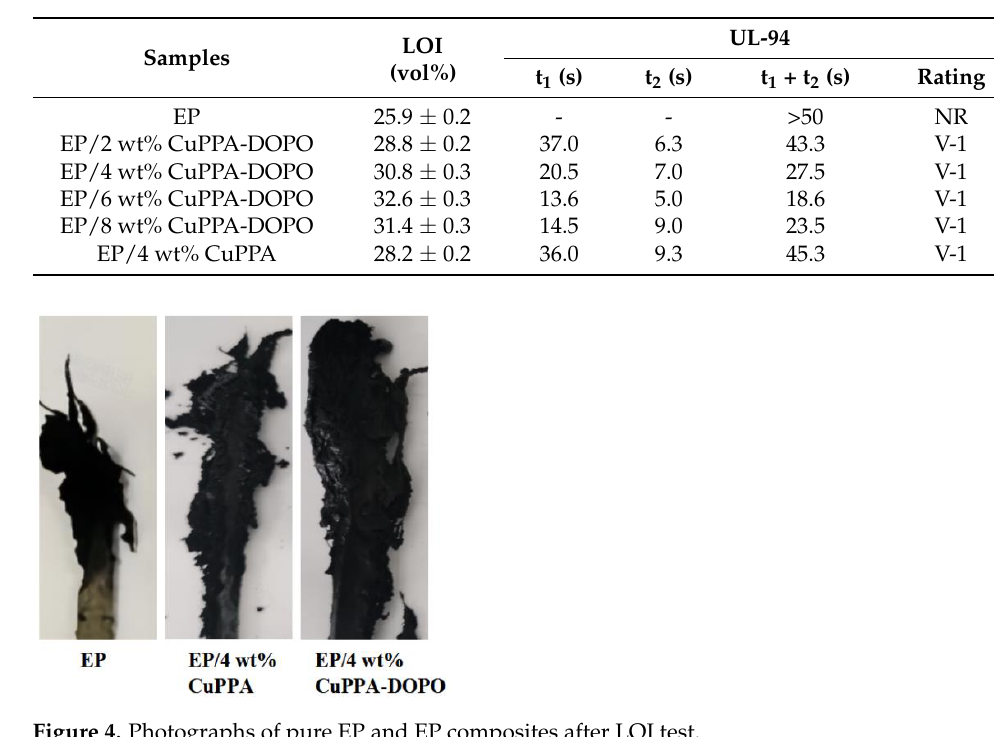
Table 2. LOI data and UL-94 results of EP composites.